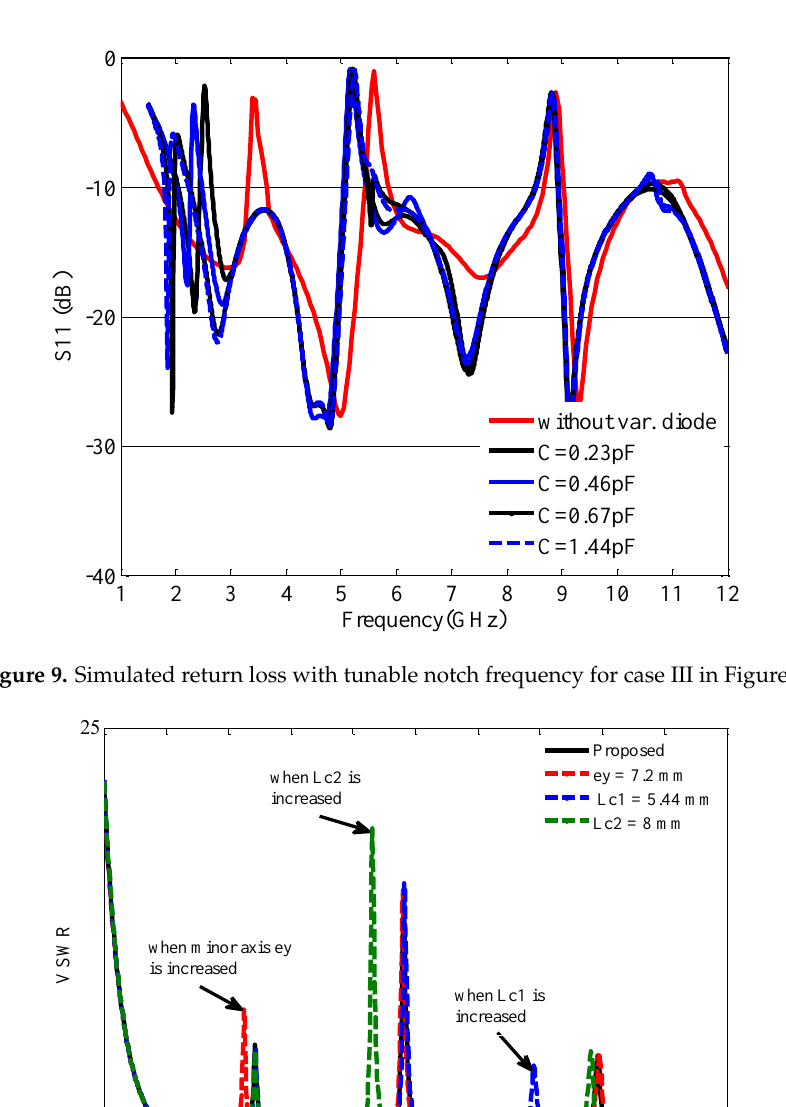
Figure 10. Parametric study of the resonator.